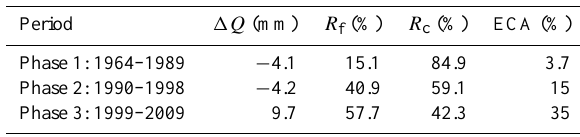
Table 5. The relative contributions of forest disturbance and climate variability on annual mean flow